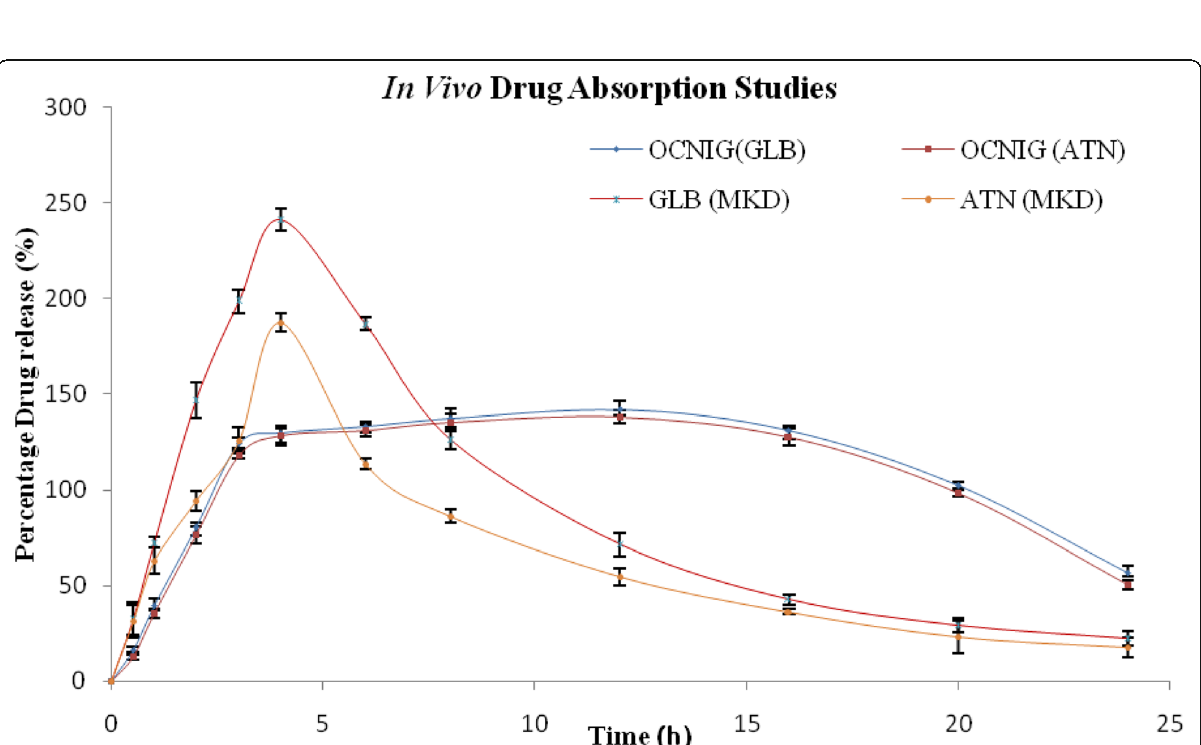
Fig. 9 In vivo drug absorption